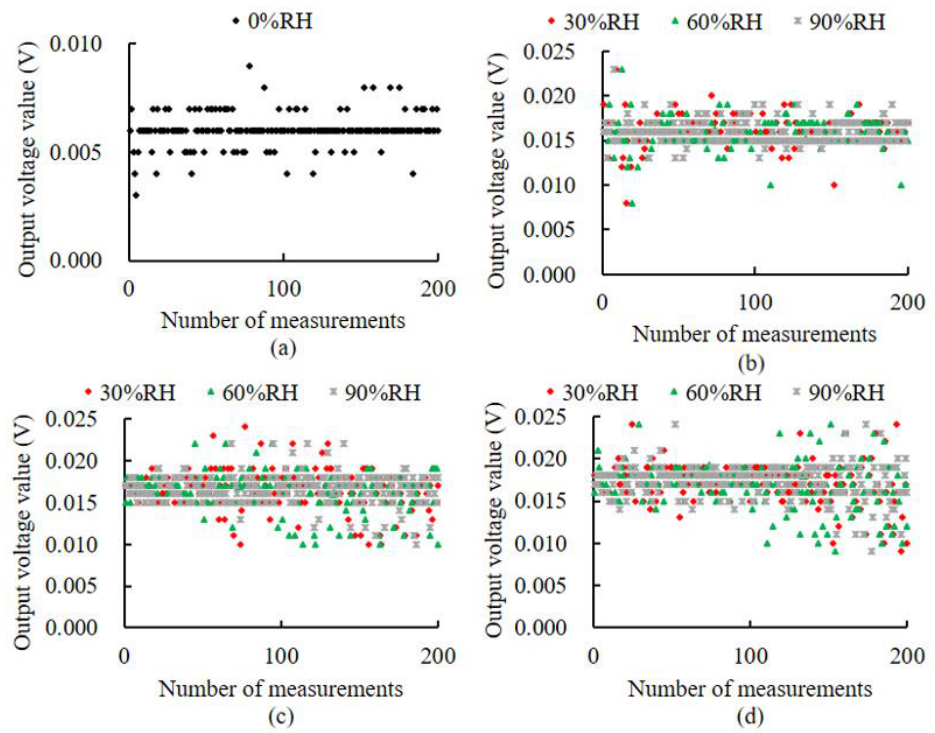
Figure 13. The response of the impedance measurement circuit to ambient temperature and humidity. ( a ) − 40 °C. ( b ) 5 °C. ( c ) 35 °C. ( d ) 65 °C.